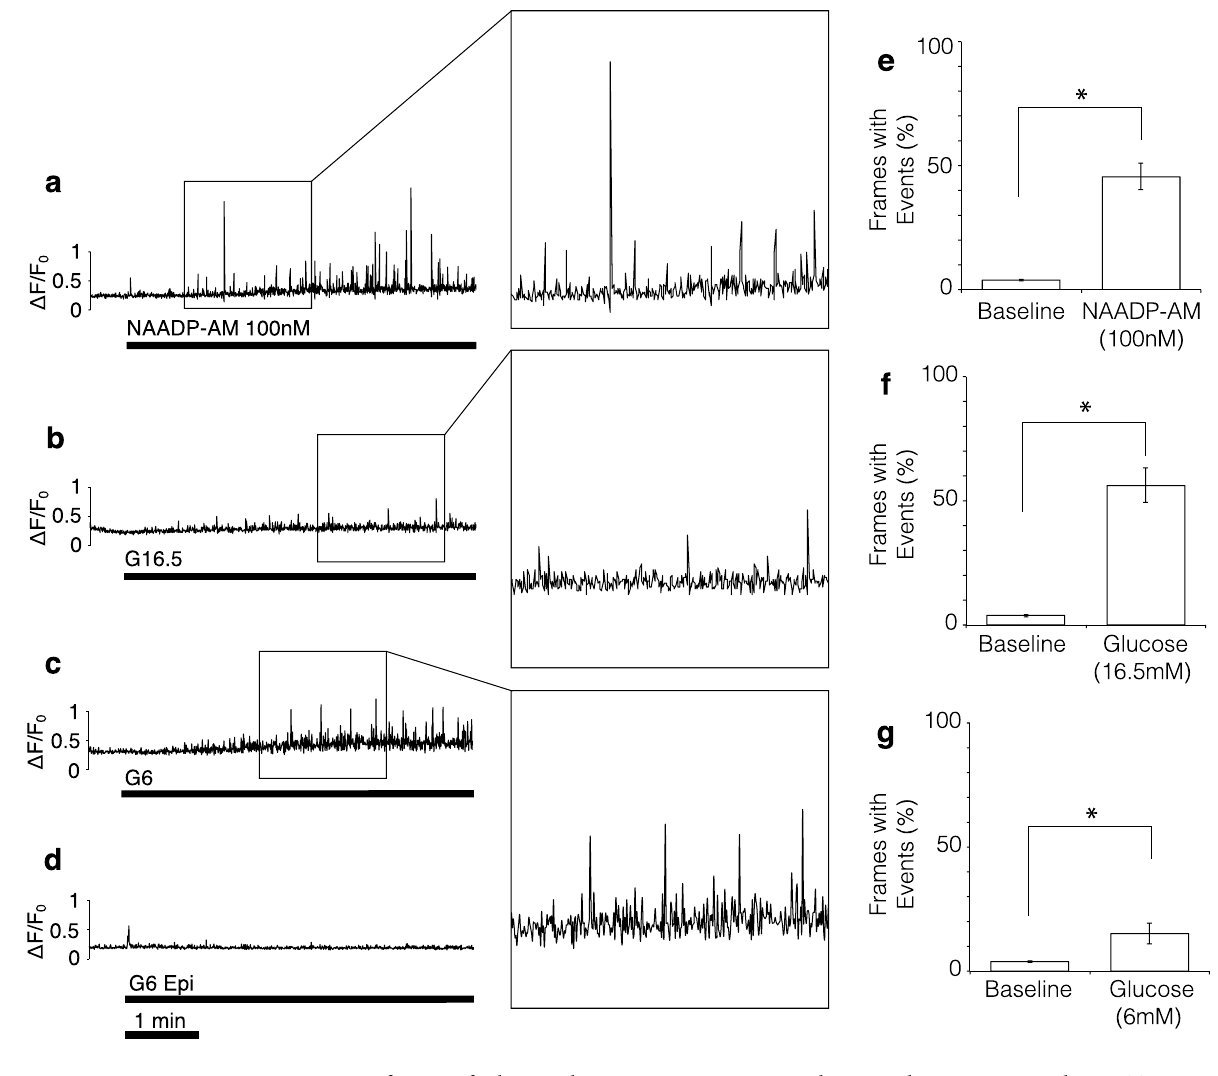
Figure 3. Quantification of calcium release events in response to glucose and NAADP-AM in low EGTA (100 μM). ( a – c ) Representative TIRF traces of β-cells stimulated with: ( a ) 100 nM NAADP-AM after preincubation with thapsigargin, ( b ) 16.5 mM glucose after preincubation with thapsigargin, ( c ) 6 mM glucose without thapsigargin preincubation. ( d ) Epifluorescence recording (all other parameters equal) using 6 mM glucose without thapsigargin preincubation. Maximum intensity change of subsequent frames after normalising to baseline plotted against time. Insets show magnified events for each of the three experimental stimuli, chosen to illustrate the variation in event size. ( e – g ) Percentage of frames showing elementary events (defined as events of an amplitude more than 2 standard deviations above baseline mean) before (baseline) and after stimulus addition. ( e ) NAADP-AM; n = 20 (8 experiments, 4 Animals), t(19) = 7.90, p < 0.01, 90% response rate. ( f ) 16.5 mM glucose; n = 14 (6 experiments, 4 Animals), t(13) = 7.44, p < 0.01, 100% response rate. ( g ) 6 mM glucose; n = 18 (6 experiments, 6 Animals), t(17) = 2.61, p < 0.01, 50% response rate. * denotes significance; paired samples, one-tailed